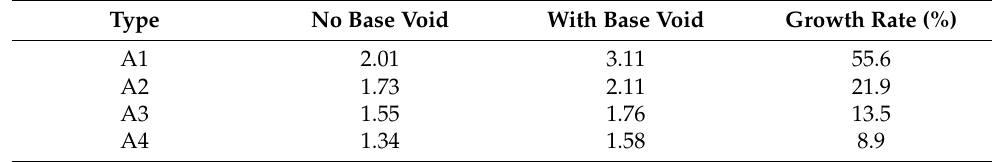
Table 4. Statistics of peak acceleration of tunnel axial measuring point (m/s 2 ).